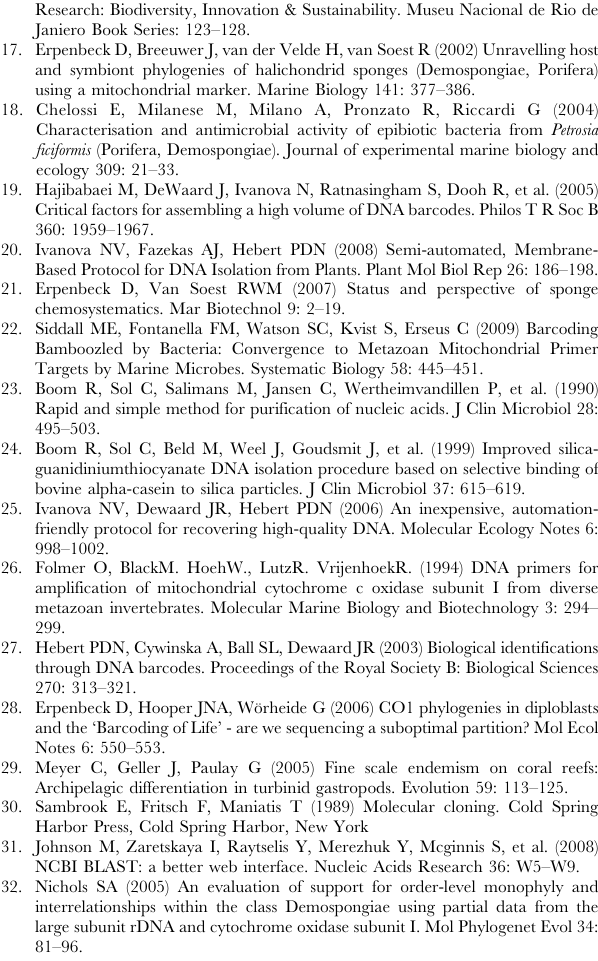
Table S1 Number of samples extracted per taxonomic groups. (DOC) Table S2 Blast results of sequenced sponge specimens. Match indicate whether the best blast match was a member of the phylum Porifera (Match= 1) or of other phylum (Match= 0). The